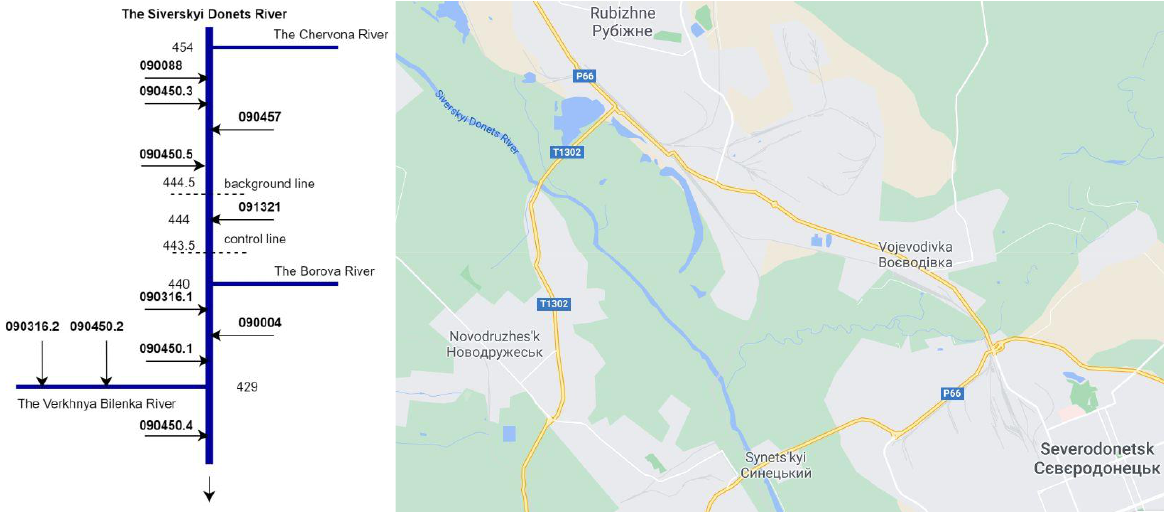
Figure 4. The investigated area and hydrographic diagram of the location of wastewater discharges, background and control